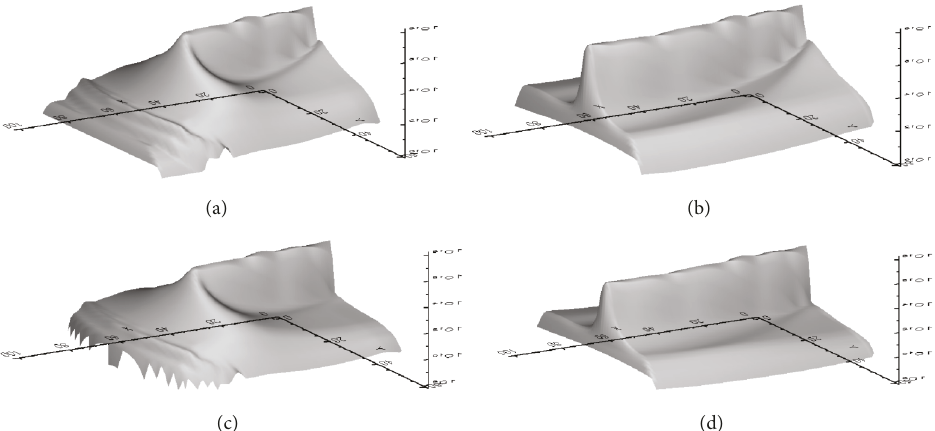
Figure 8: Scenario D: the top row shows two snapshots of the “heavy jet” run4 (run4 parameters in Table 1), using the hydrodynamical density 𝜌 as the emission coefficient (arbitrary units). The jet makes its way through the surrounding winds, piling up matter ahead of its head and around the jet shock front, as well as around the jet base (remnants of the accretion disk wind). The bottom row shows the line of sight integrationimages of the same scenario (D), where now 𝜌𝑢 2 is the emission coefficient.This time only matter that is both fast and dense, simultaneously, does contribute to the emission. The jet base, therefore, now emits much less, since, only the jet flow there is both fast and dense, whereas the remnants of the wind constitute dense but slow matter. The impact of resolution effects, from near the jet base, can also be seen as humps on the back of the jet intensity